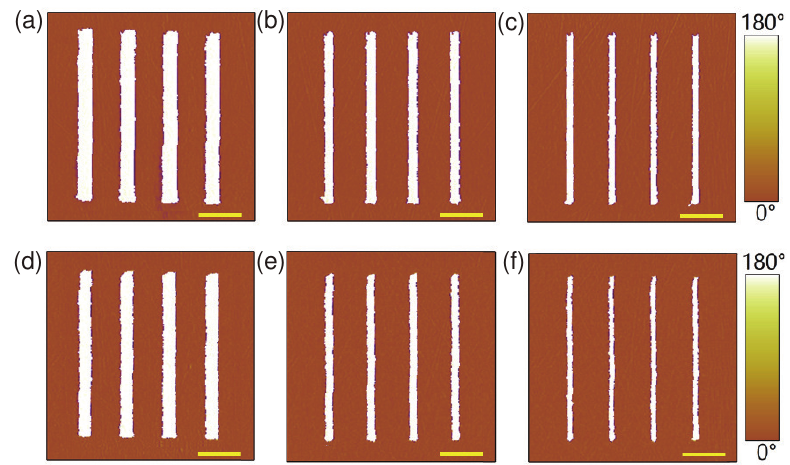
Figure 4. The thermal stability of stripe domains in a sample that underwent a pre-heat treatment at T p = 150 ◦ C for 2 h. ( a – c ) PFM images of as-written stripe domains before the thermal annealing treatment. ( d – f ) PFM images of stripe domains after the thermal annealing treatment at 120 ◦ C for 1 h. The length of the stripe domains was set to be ∼ 4 µ m. Here, the tip voltage used to fabricate the stripe domains was the same as that in Figure 2. The scale bar is 1 µ m in all